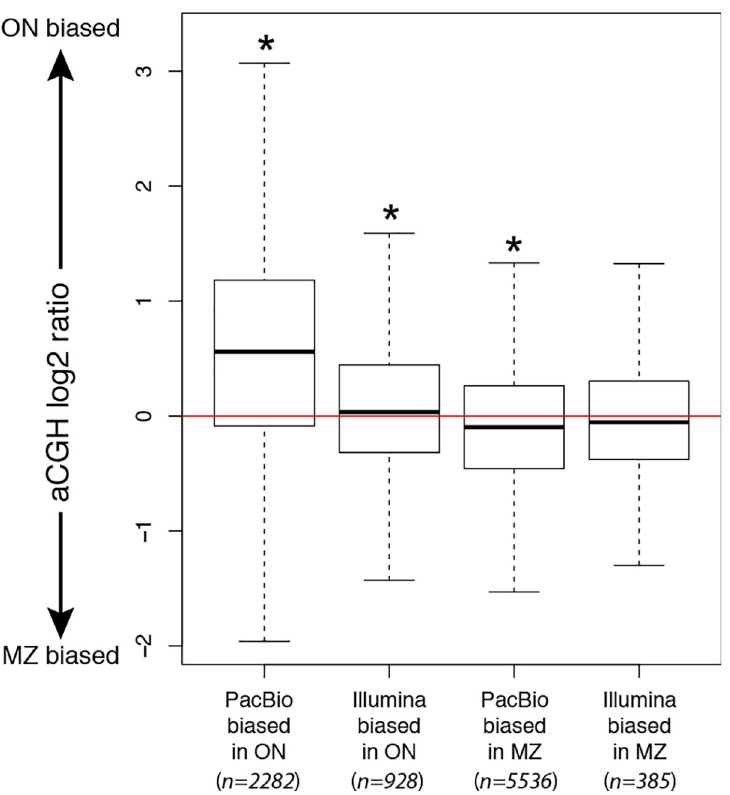
Fig 2. Intra-species NGS platform bias and relationship to inter-species aCGH bias. aCGH log 2 hybridization ratios of probes with variable numbers of hits between sequencing technologies are significantly different from the full distribution of aCGH ratios in the direction of PacBio biased probes. � Significance is indicated for pairwise Tukey’s HSD tests at FDR < 0.05.